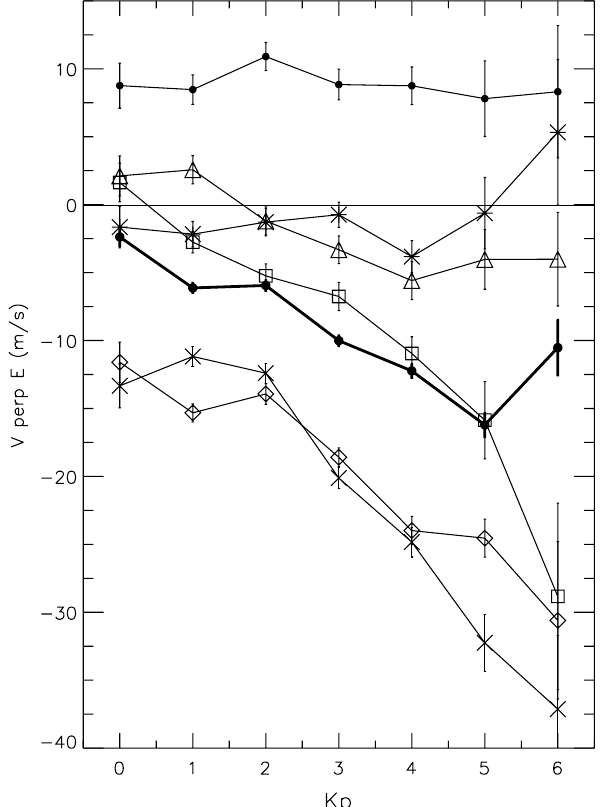
Fig. 9. The same as Fig. 8 except for V ⊥ E . The results are given for the same 4-h intervals of LST: 00–04 h (diamonds), 04–08 (as- terisks), 08–12 (small dots), 12–16 (triangles), 16–20 (squares), and 20–24